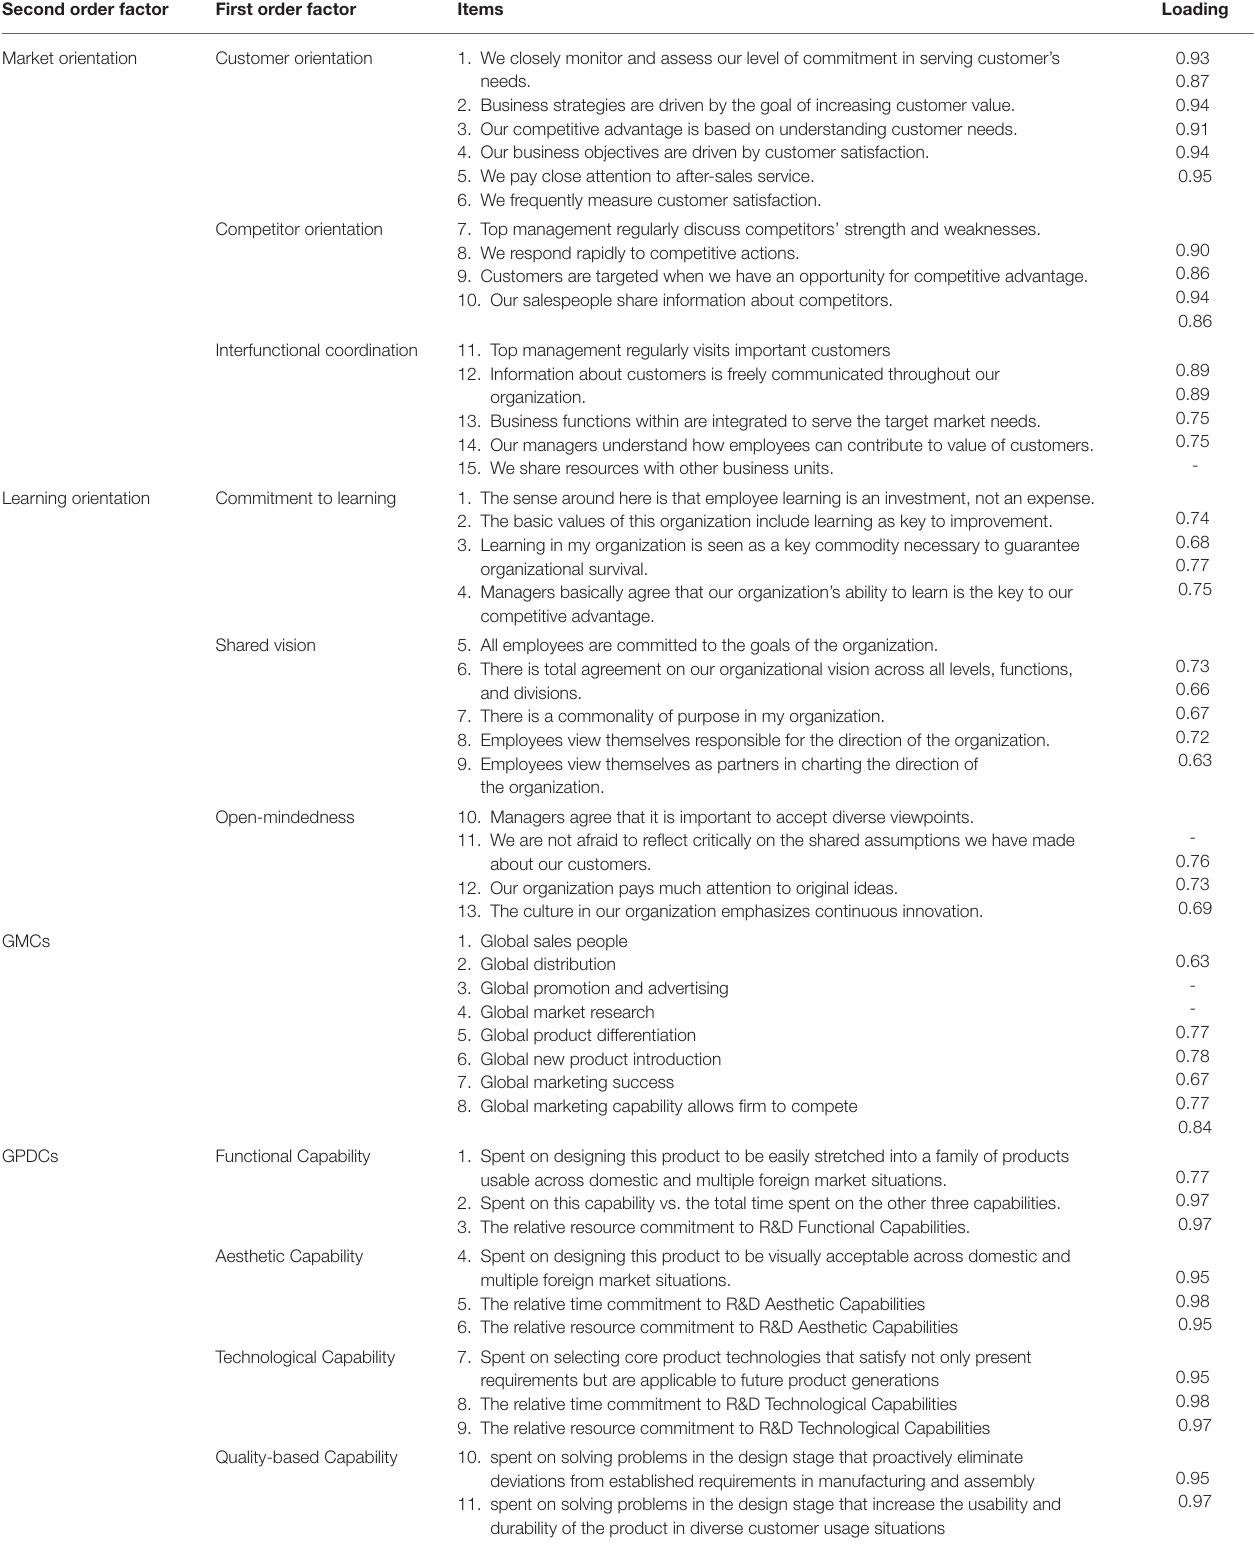
TABLE 1 | Scales items factor